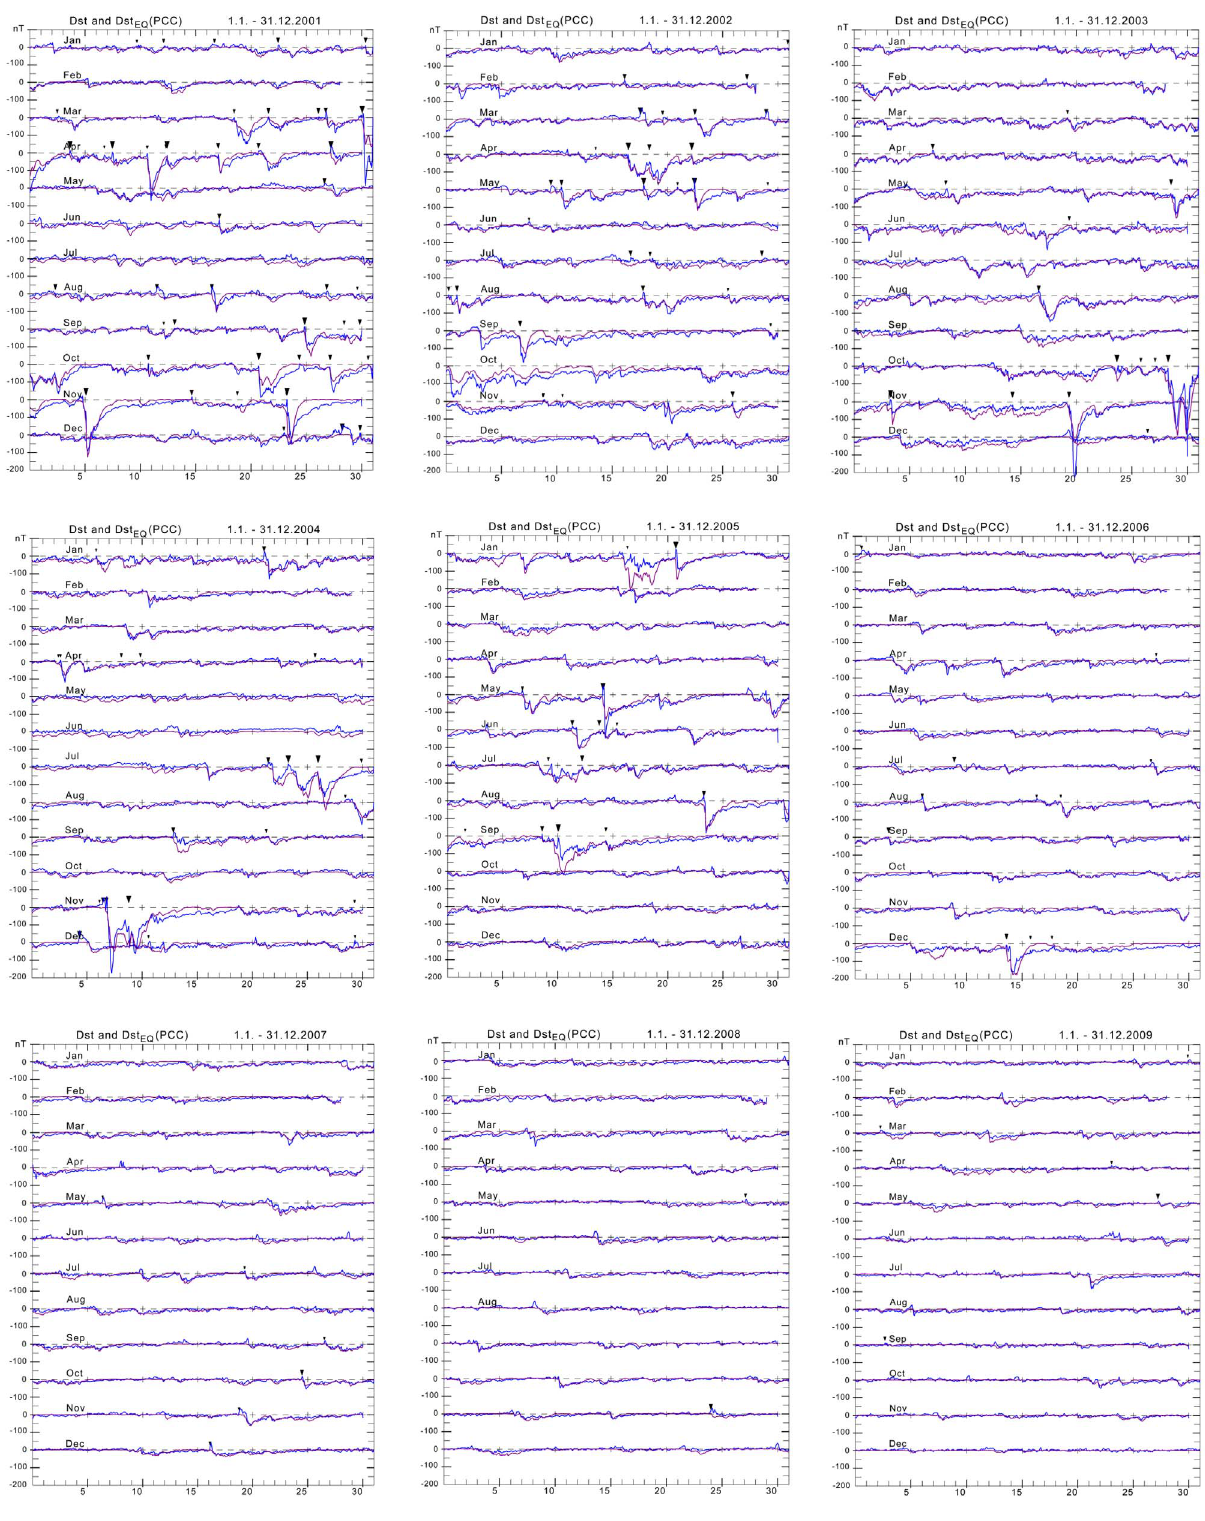
Fig. A2. Dst and Dst EQ 2001 –